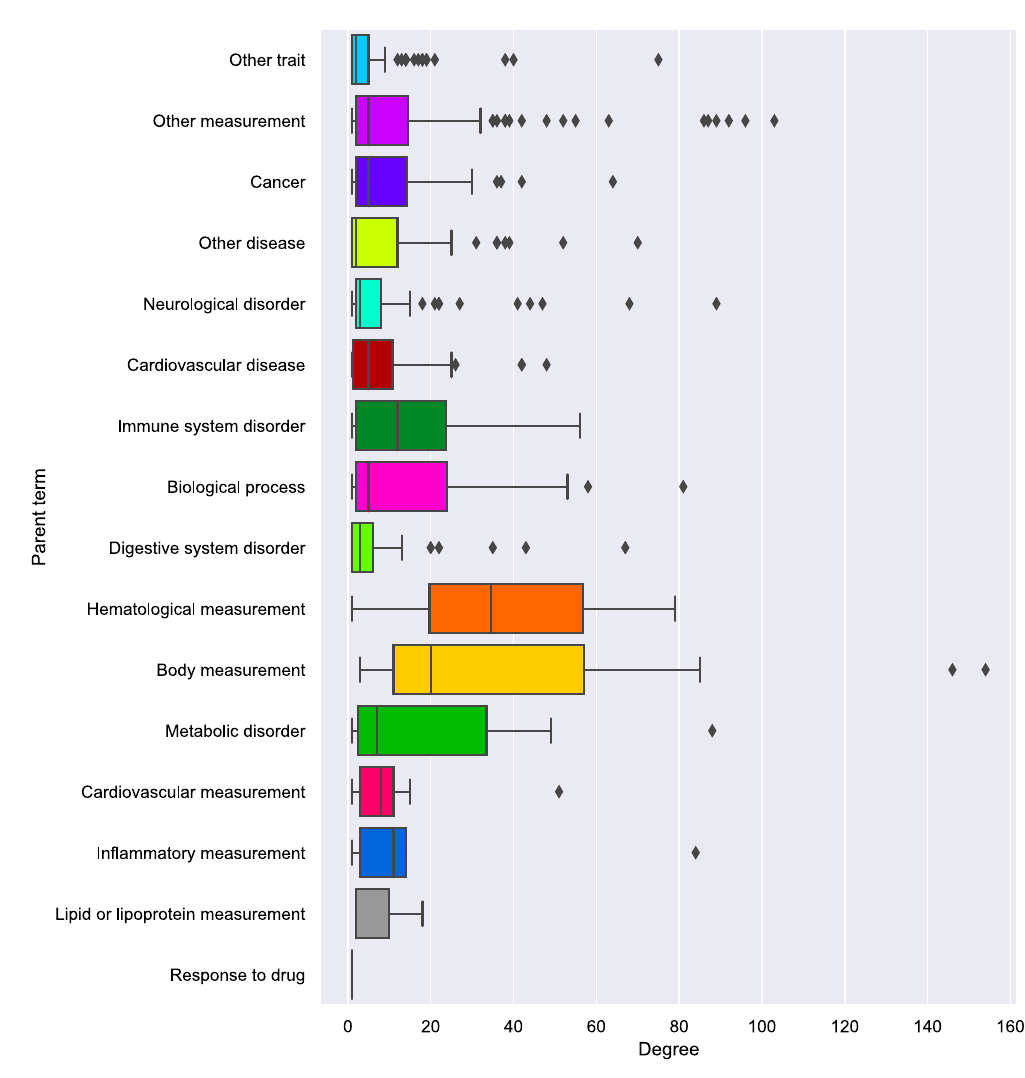
Figure 3. Degree distribution by trait category. Trait categories are defined by the EFO ontology system parent terms.